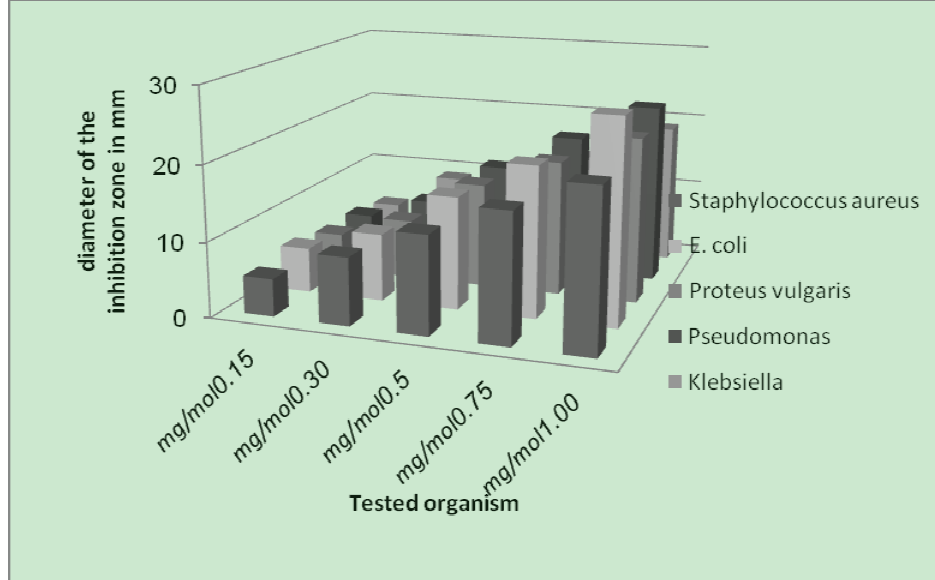
Figure 6. Effect of Cu-complex toward test organisms.